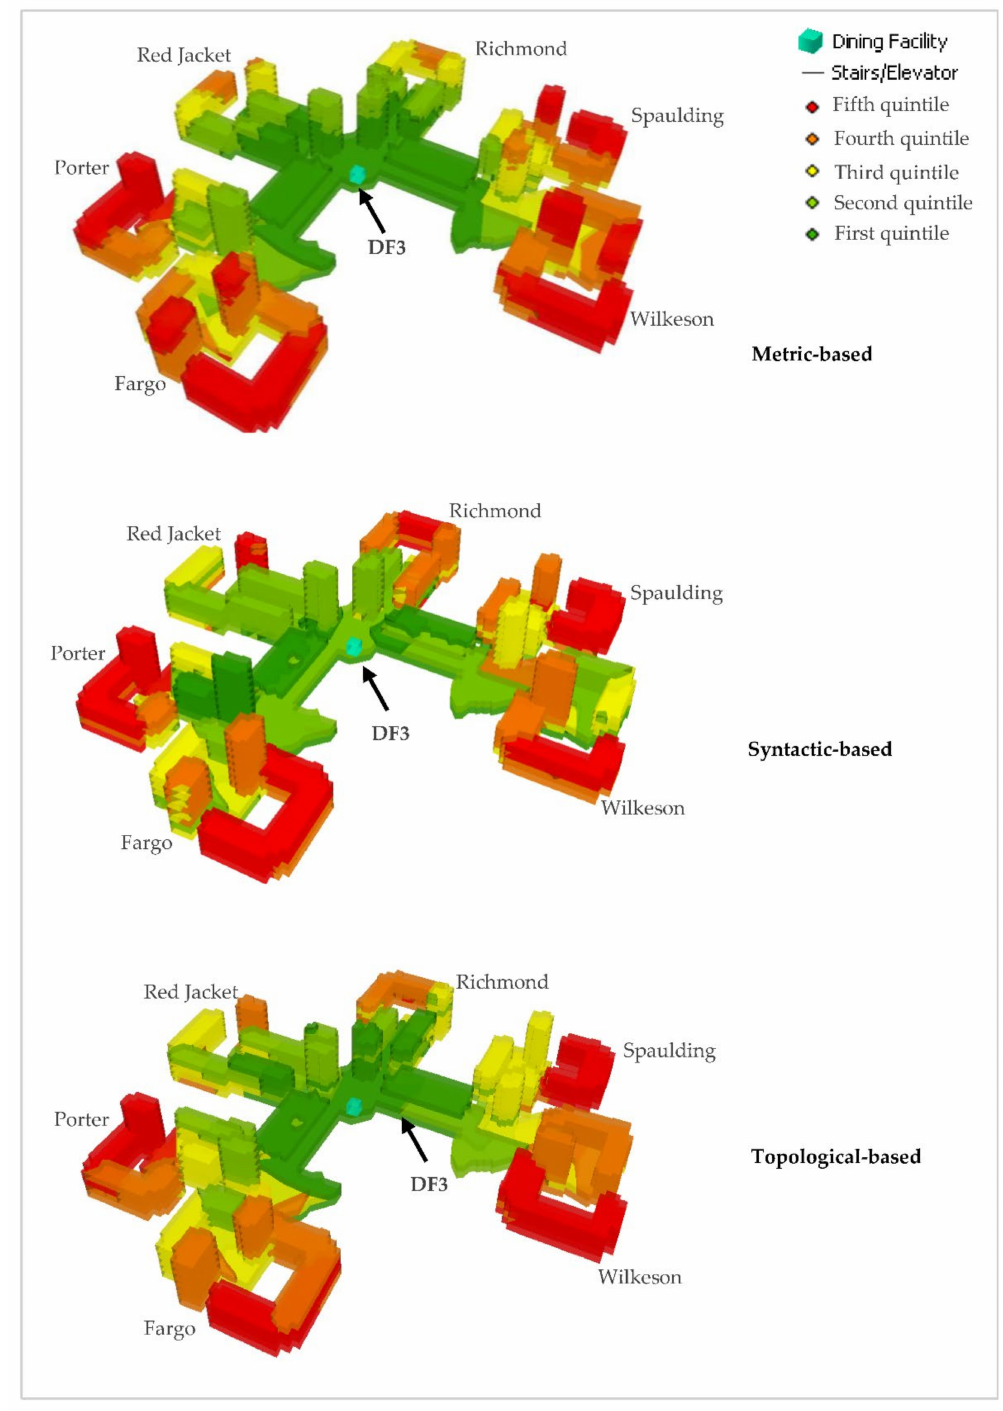
Figure 17. Metric, syntactic, and topological accessibility to dining facility 3: classification in